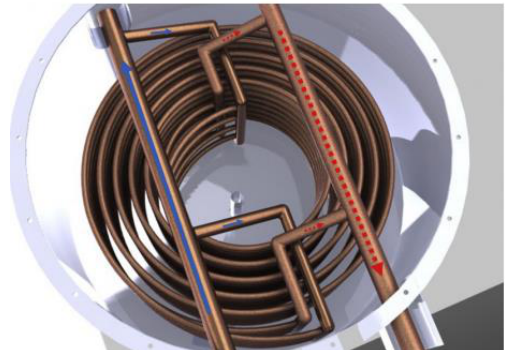
Figure 3 Upper view of the tank [18]